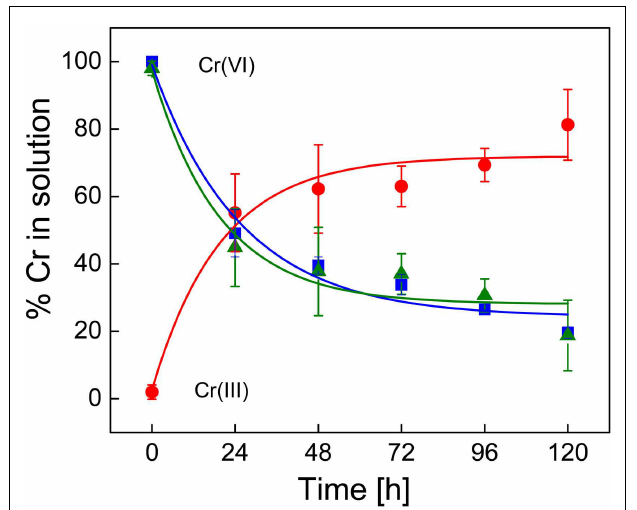
FIGURE 3 | Chromate reduction in cultures of G. metallireducens and the filtered spent medium. The cells grown on nitrate for 60h were exposed to 100 µ M chromate then incubated for 120h.Whole cells ( (cid:4) ) and • • ). Each filtered spent medium (